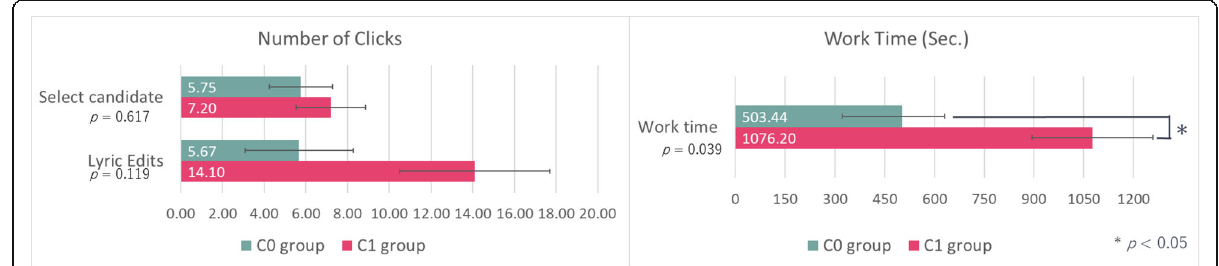
Fig. 10 Comparison of number of clicks and work time between C0 and C1 groups